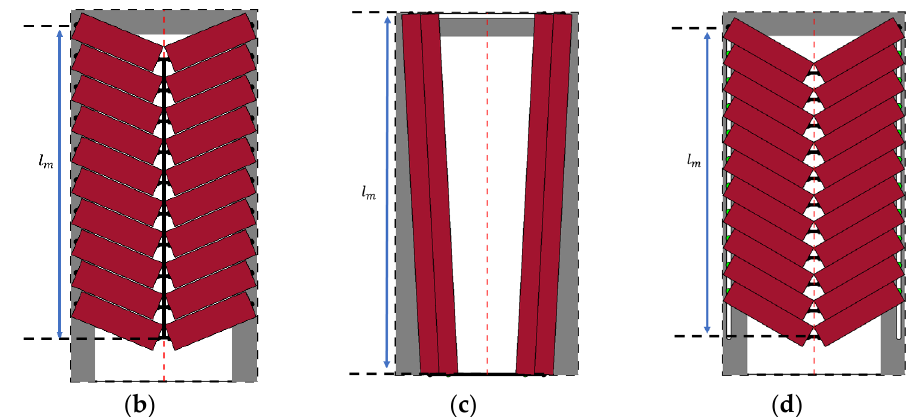
Figure 4. Muscle length for bipennate muscle bundles with ( a ) laterally arranged fibers and pinned boundary condition, ( b ) centrally arranged fibers and pinned boundary condition, ( c ) laterally arranged fibers and fiber contact boundary condition, and ( d ) centrally arranged fibers with fiber contact boundary condition.